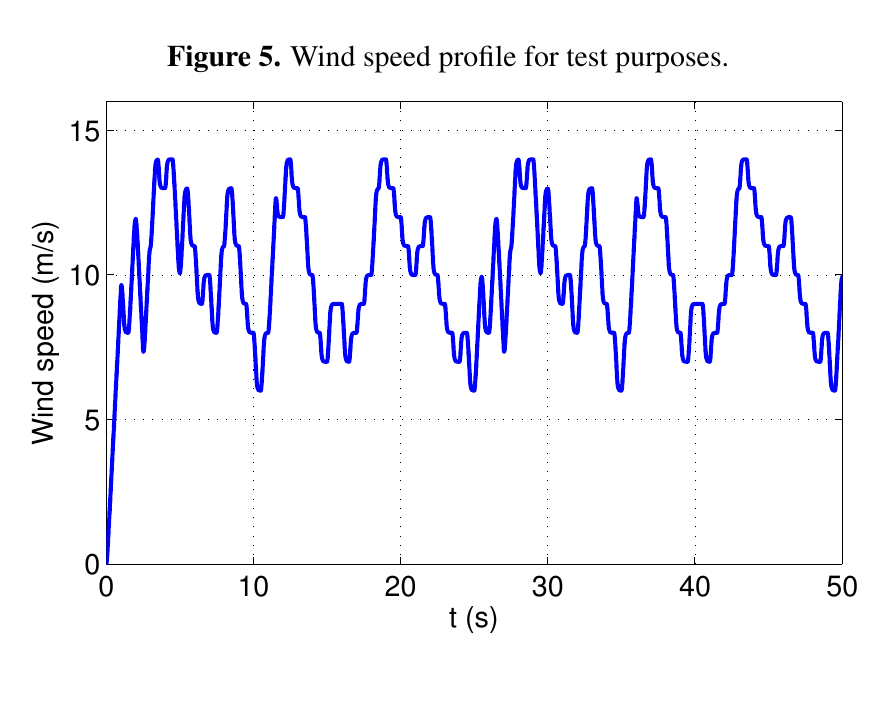
Figure 6. Real and simulated rotor